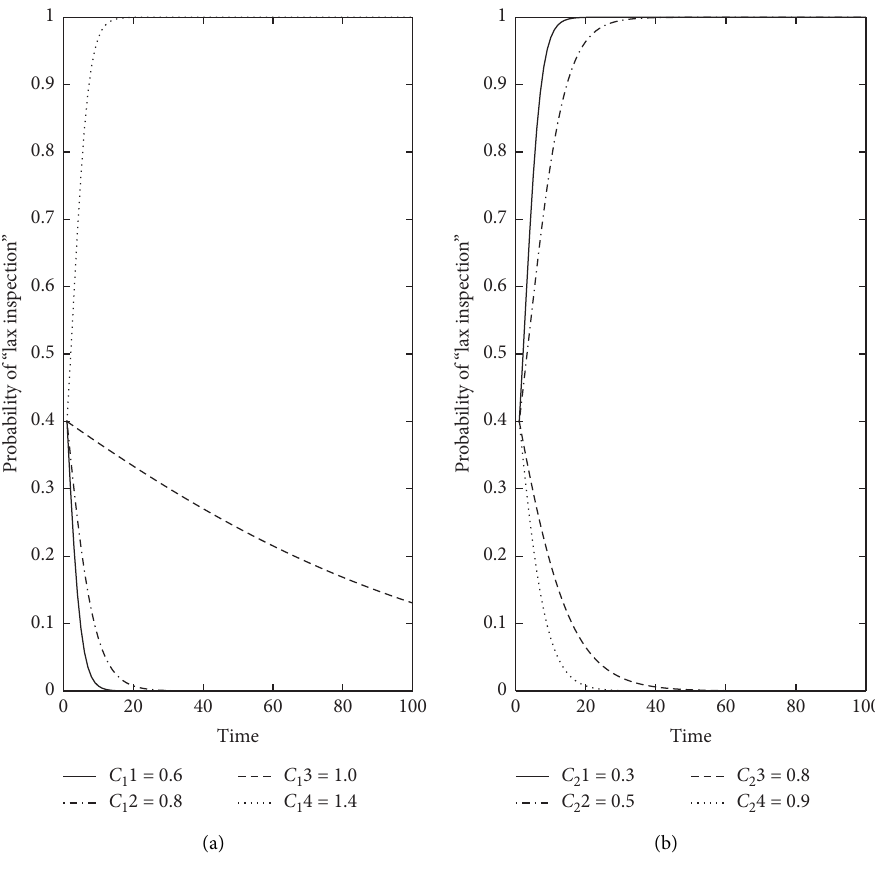
Figure 8: The effects of inspection